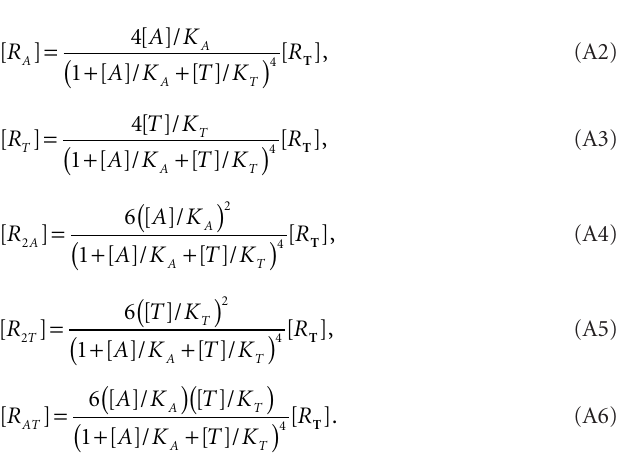
Figure 6 | Histograms of LacZ polypeptide molecule count per bacterium, calculated from stochastic simulations carried out with the set ([ G shown in Figure 4C and [ T